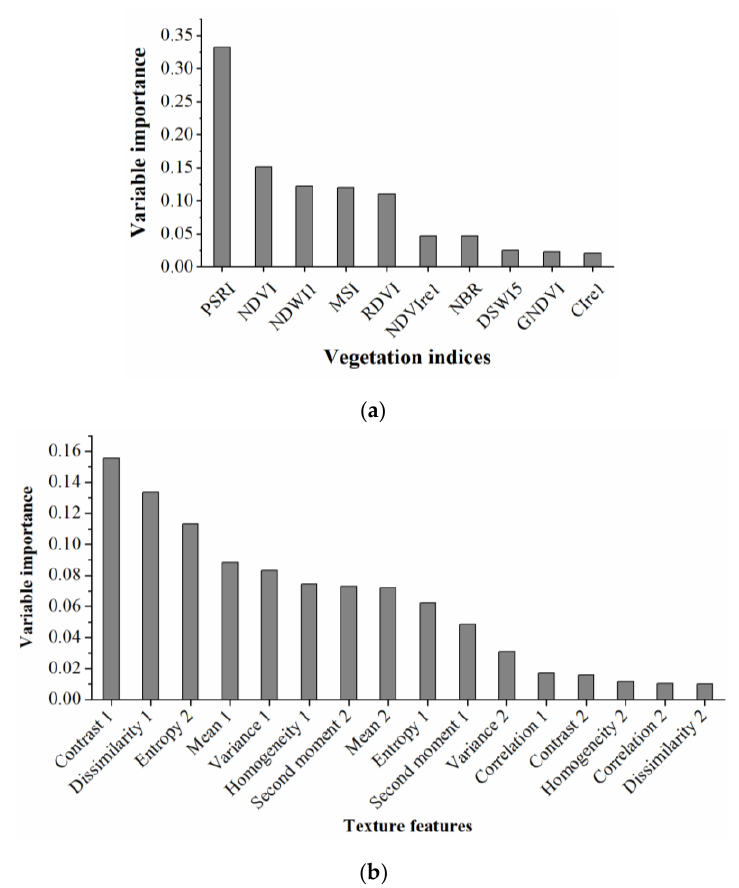
Figure 5. Rankings of ( a ) spectral indices and ( b ) texture features based on their importance for cotton root rot classification through random forest (RF) models.